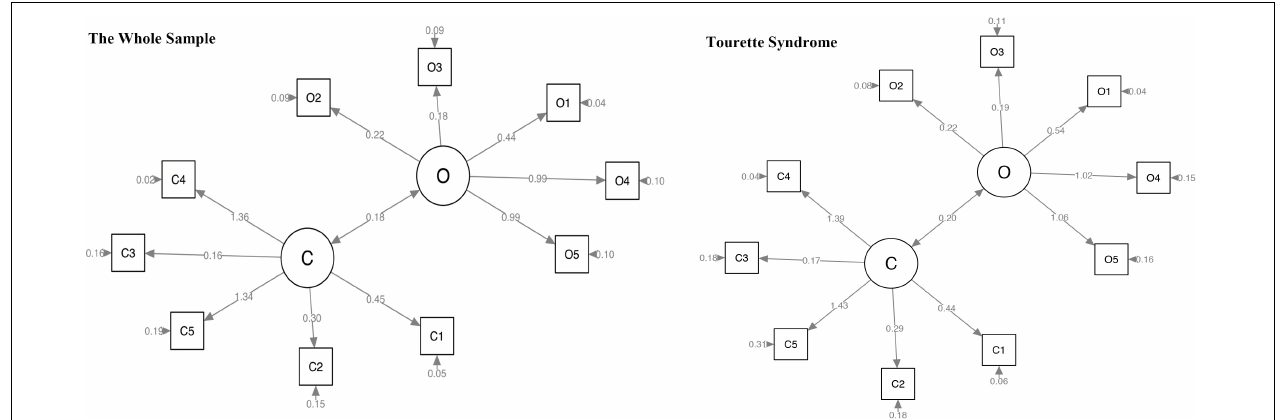
FIGURE 1 | Confirmatory factor analysis of CY-BOCS in the whole sample and the TS group. CY-BOCS, Children’s Yale–Brown Obsessive–Compulsive Scale; TS, Tourette syndrome.